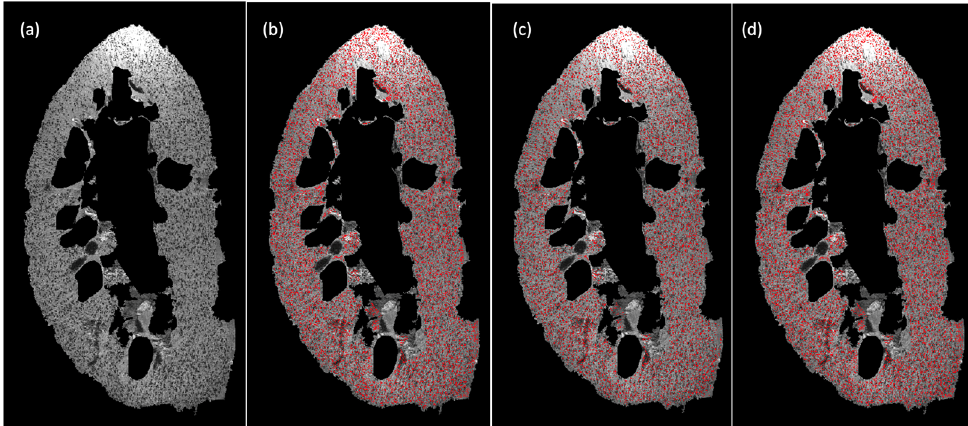
Figure 3. Glomerular segmentation results from 3D MR images of human kidney (CF1 slice 256). ( a ) Original magnitude image. ( b ) Glomerular segmentation results of BlobGAN trained on entire dataset (1000 random samples). ( c ) Glomerular segmentation results of BlobGAN trained on IED- Coreset ( k = 10). ( d ) Glomerular segmentation results of BlobGAN trained on FDD-Coreset ( k =